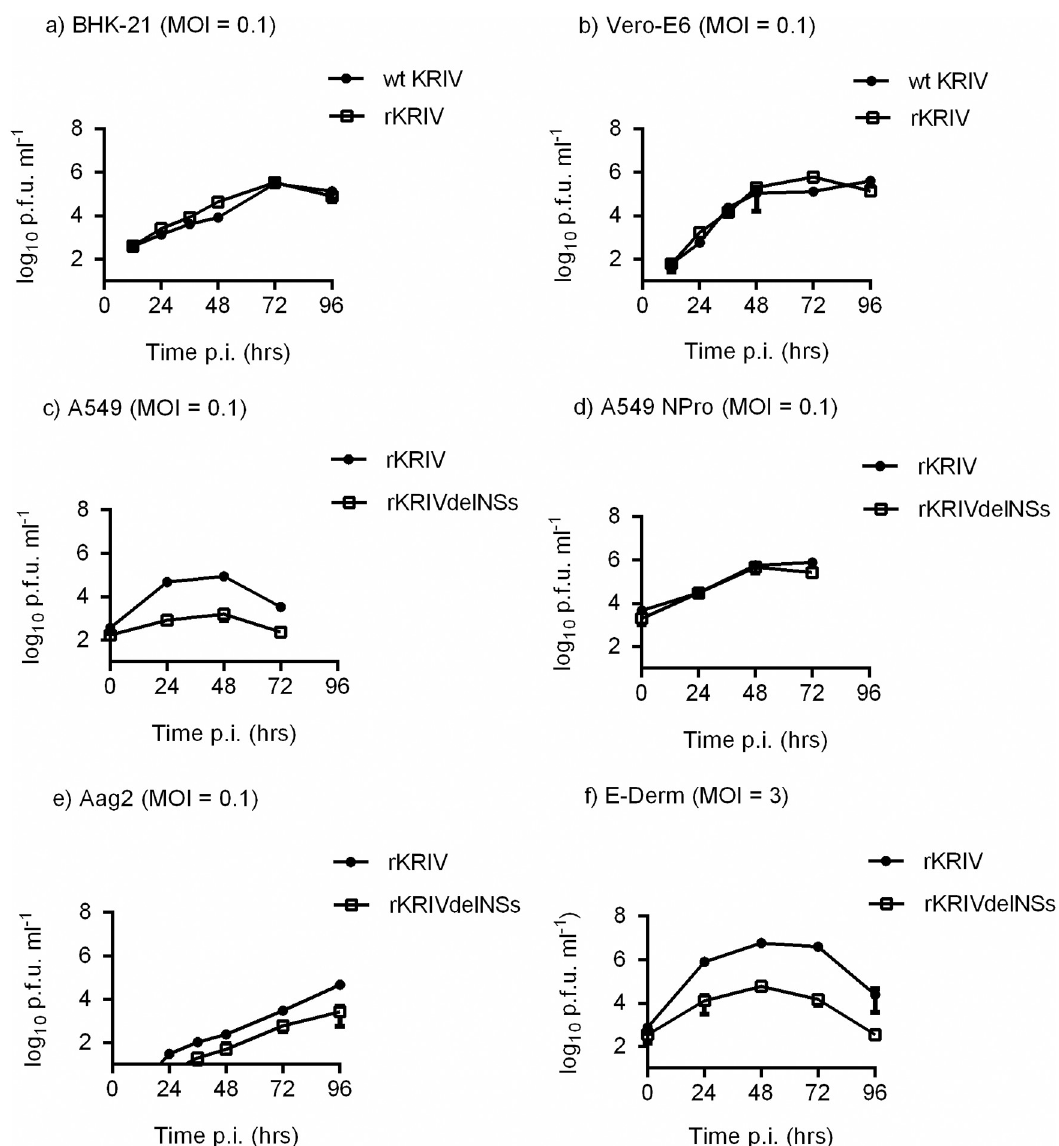
Fig 4. KRIV growth in cell culture. Cell lines BHK-21 (a) , Vero-E6 (b) A549 (c) , A549 Npro (d) Aag-2 (e) and the equine cell line, E-Derm (f) were infected at a MOI of 0.1 or 3 as indicated. The curves show the titre of KRIV accumulated after 12 or 24 hr intervals. The titre of virus at each time point was determined by a plaque assay; virus titres are indicated in PFU/ml. Representative experiments are shown (n = 2). Error bars indicate SD.